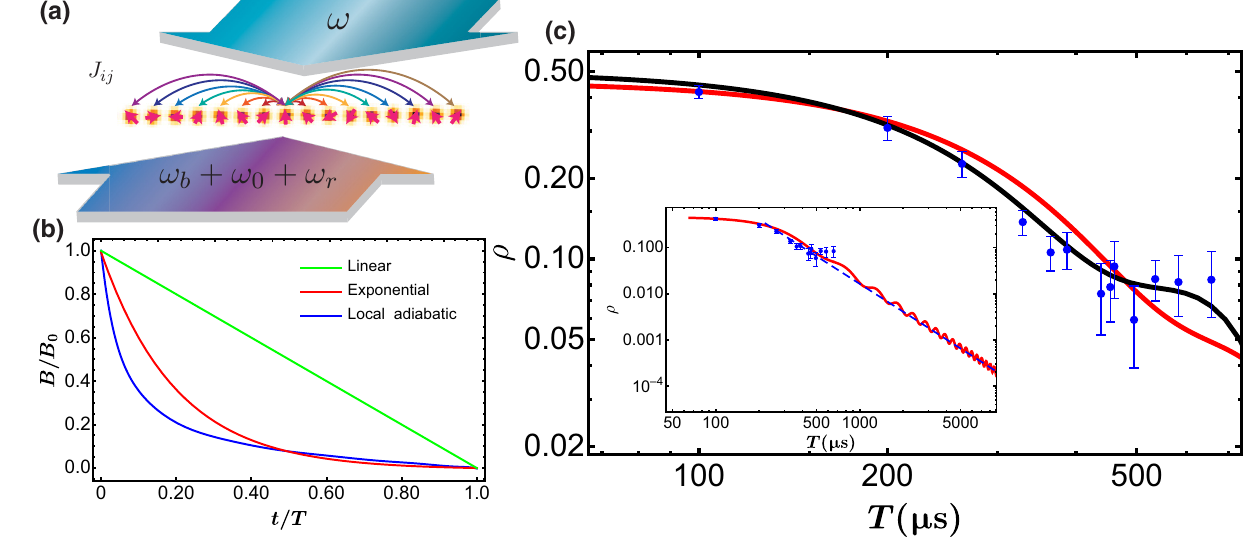
FIG. 1. Experimental scheme. (a) The Ising model Hamiltonian is achieved on a chain of up to 61 ions using two counterpropagating 355-nm global Raman laser beams. (b) There are different paths to quench the transverse field. The original Kibble-Zurek mechanism (KZM) assumes a linear quench (green). In this experiment, restricted by the coherence time of the ions under strong driving laser, a local adiabatic path (blue) can be used to optimize the adiabatic condition over the whole ramping dynamics, thus allowing us to enter the adiabatic regime as shown in (c). Later when probing the KZM for multiple ions, we take an exponential path (red) for both theoretical and experimental convenience. (c) To illustrate different regions of the quench speed, we consider two ions with ferromagnetic coupling J 0 = − 2 π × 450 Hz. Starting from a fully polarized state | ↑ y ↑ y (cid:4) in the y direction, which is close to the ground state under B 0 = 6 | J 0 | , we ramp down B ( t ) following the local adiabatic path. For sufficiently low quench time, the defect = ± 1 for the two ions. As the quench time increases, density ρ is close to 1 / 2, namely a random and independent distribution σ i x the defect density decays as more and more population remains in the ferromagnetic ground states. The blue dots with error bars representing one standard deviation are the experimental data, which agree well with the theoretical results (solid black curve). It deviates slightly from the solid red curve, which is the theoretical result when starting from the true ground state under B 0 rather than the fully polarized state. As shown in the inset, for the two-ion case with a large energy gap, we are just able to enter the adiabatic regime where the defect density follows ρ ∝ T − 2 (dashed line). For larger ion numbers and thus smaller energy gaps, we are not able to dive deep into the adiabatic regime, but the critical behavior can still be probed by the